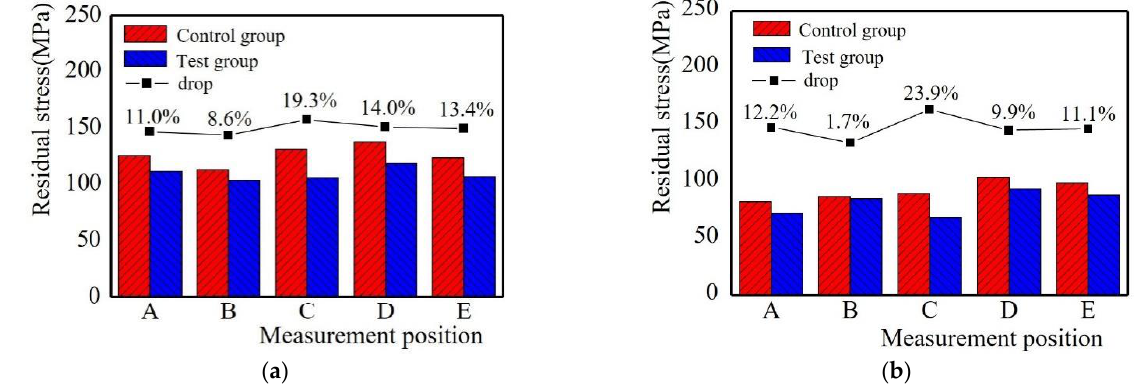
Figure 15. Verification test: ( a ) Residual stress in X direction; ( b ) Residual stress in Y direction.